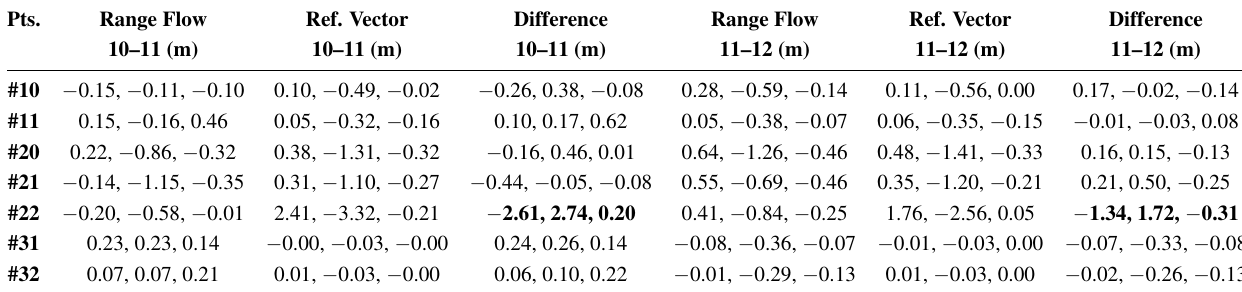
Table 1. Comparison between the estimated motion (U,V,W) and the reference data.